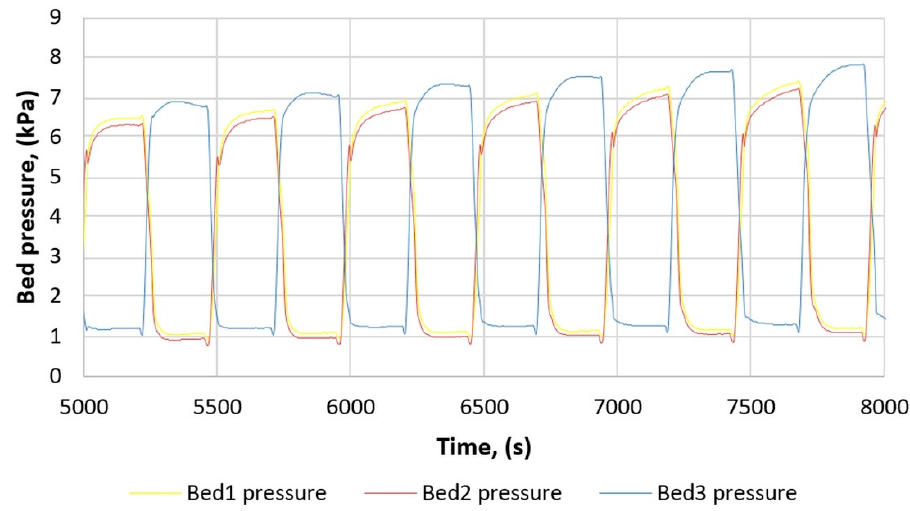
Figure 8. The changes in the pressure of beds in the function of time.